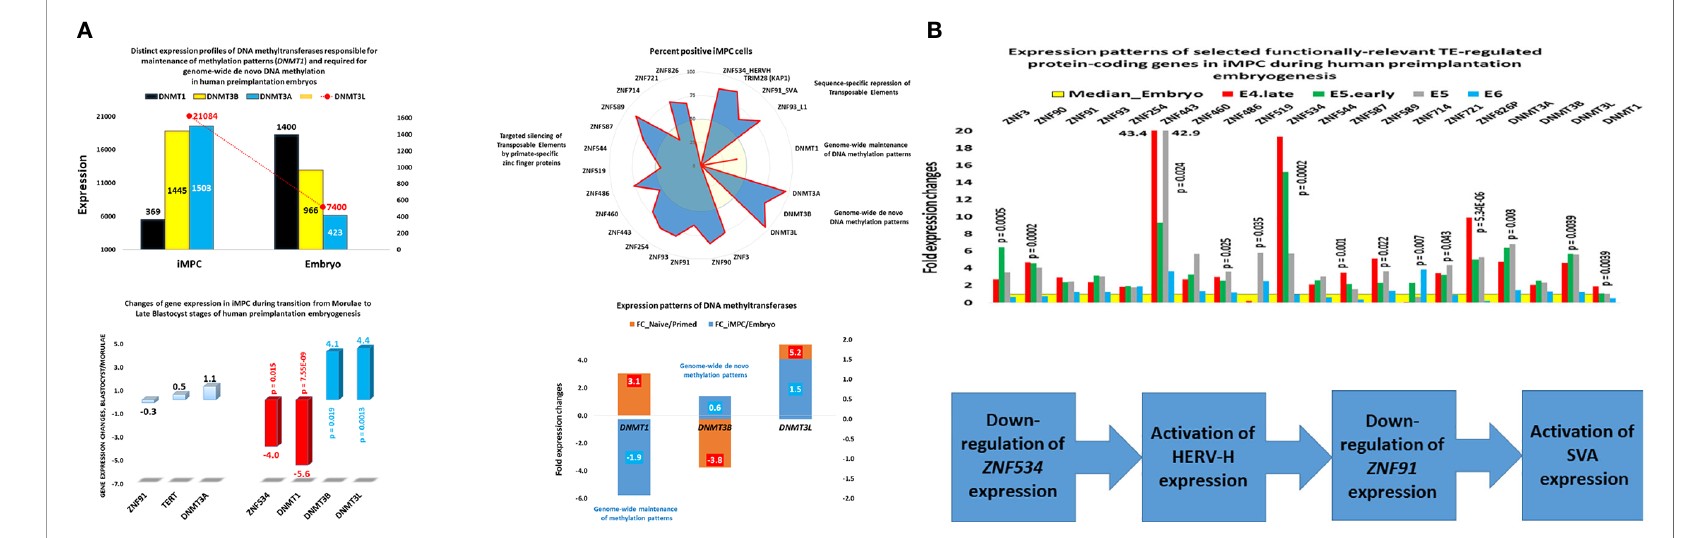
FIGURE 1 | Expression changes of genes encoding DNA methyltransferases and primate-speci fi c zinc fi nger proteins in human embryonic MLME cells. (A) Telomerase-positive MLME cells manifest decreased expression of the DNMT1 gene, which is responsible for genome-wide maintenance of DNA methylation patterns, and increased expression of genes responsible for genome-wide de novo methylation patterns ( DNMT3A, DNMT3B, DNMT3L ). (B) Concurrently, MLME cells exhibit decreased expression of primate-speci fi c zinc fi nger proteins responsible for sequence-speci fi c silencing of SCARS and other TE-harboring loci during human preimplantation embryogenesis. Collectively, these changes of gene expression cause marked reprogramming of DNA methylation patterns in genomes of MLME cells and are associated with activation of SCARS expression. MLME cells are designated as immortal multi-lineage precursor cells, iMPC